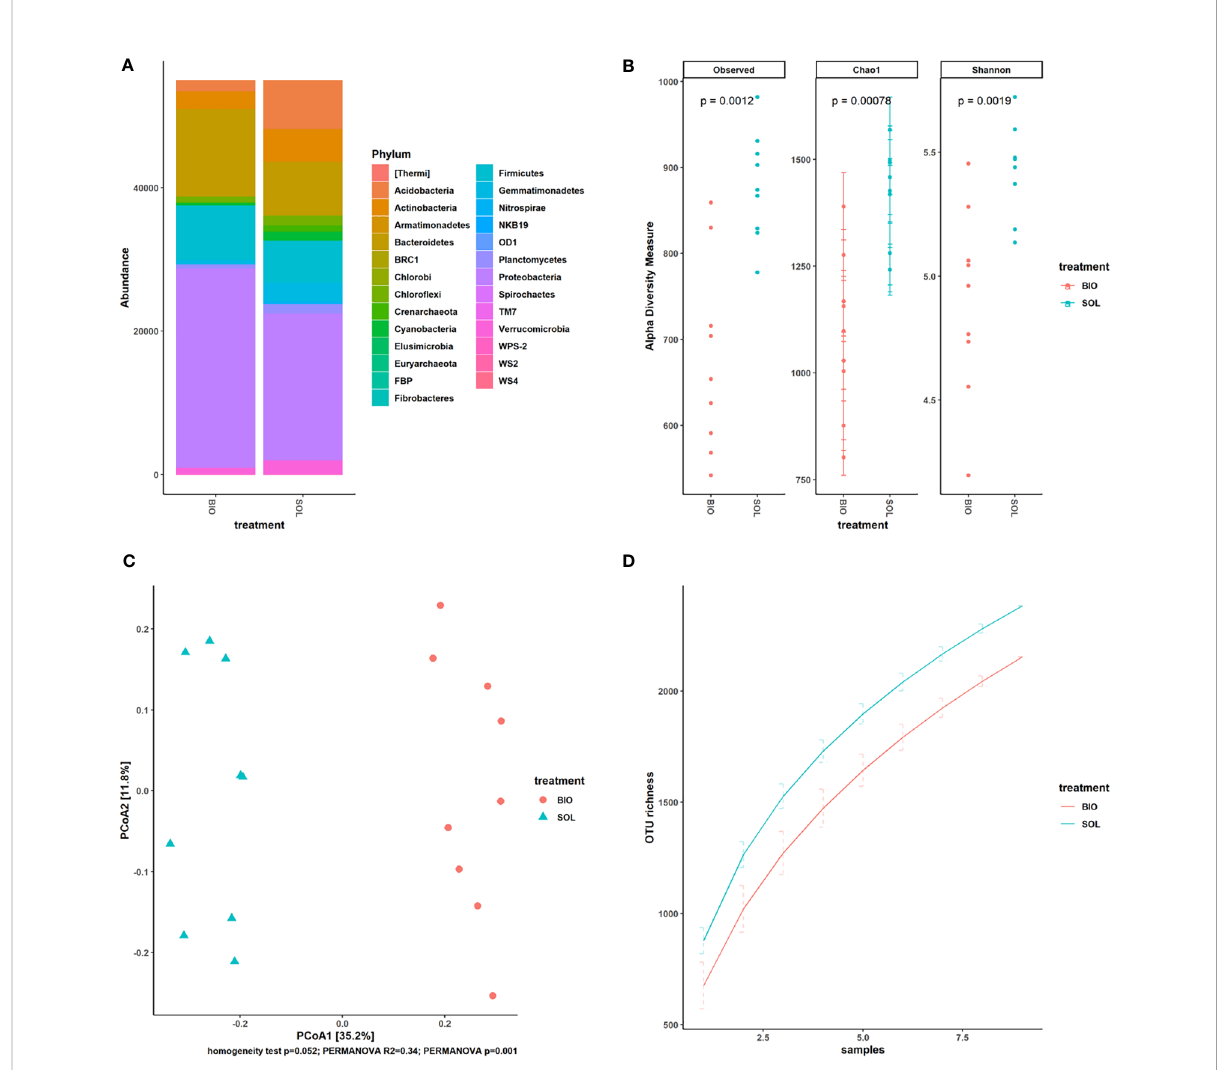
FIGURE 4 Microbiome diversity comparison between solarized and biosolarized pretreated plants. OTU counts of solarized (SOL) and biosolarized (BIO) plants (n=18) were rare fi ed. (A) comparison of the abundance of taxa by phylum (n=9). (B) Alpha diversity analysis using observed species, Chao1 and Shannon indices together with p-values (signi fi cance was tested using an unequal-variance Mann-Whitney U test). (C) Beta diversity analysis with Principal Coordinates Analysis (PCoA) using Bray-Curtis dissimilarity. Signi fi cance was tested via PERMANOVA. (D) Gamma diversity analysis using geocluster accumulation curves for mean OTU richness from a random sampling of geoclusters ±